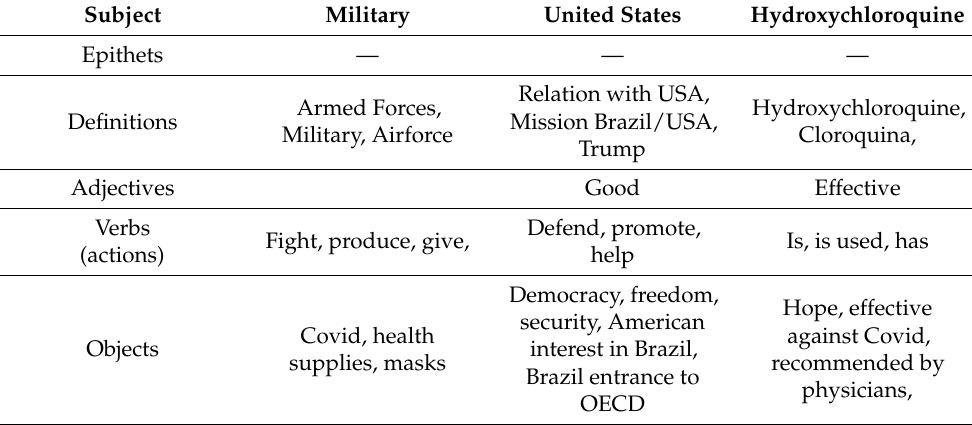
Table 17. Military, United States, and Hydroxychloroquine.